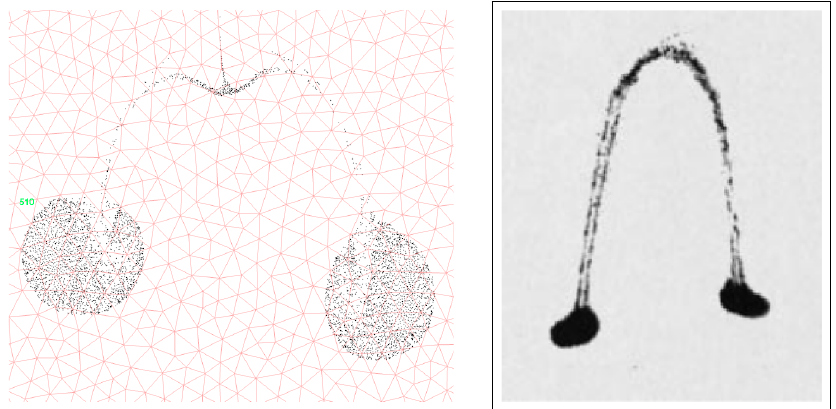
Figure 2: Division of the swarm (comparison with the experiment of Machu et al.